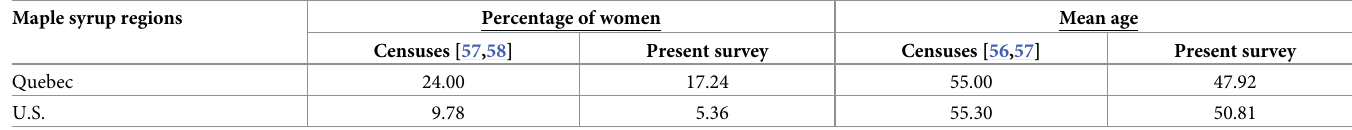
Table 2. Comparisons between the percentage of women and mean age of maple syrup producers in Quebec and the U.S. with the results of our survey. Maple syrup